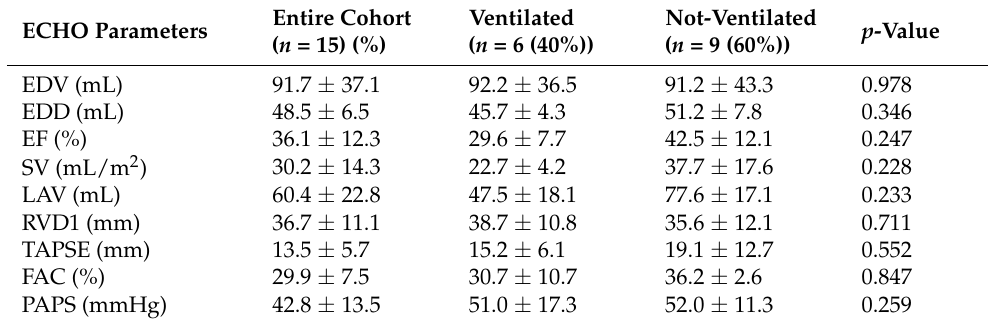
Table 3. Echocardiographic data at admission. The data are reported as mean ± standard deviation.